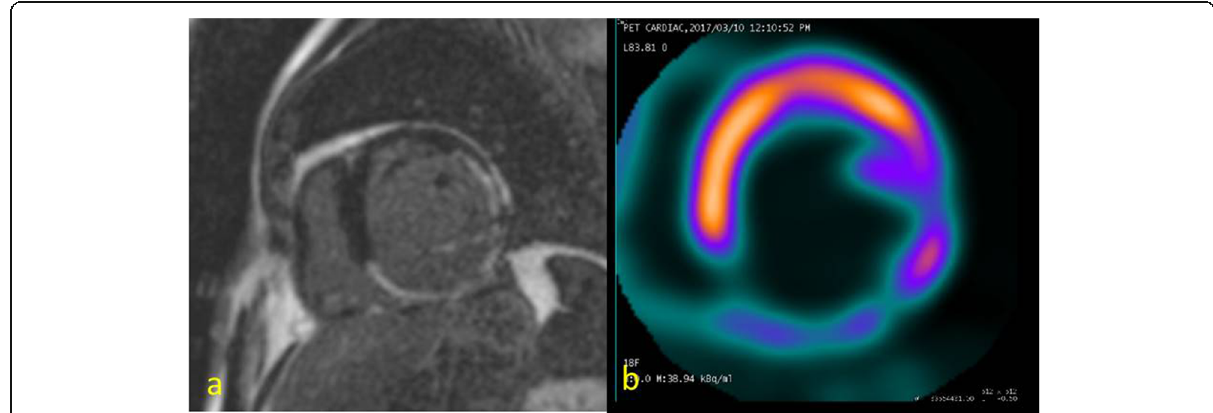
Fig. 1 A 64-year-old male with triple vessel disease. a Free-breathing delayed contrast-enhanced MRI in short-axis view reveals late gadolinium enhancement in < 50% myocardial thickness suggestive of subendocardial infarct in left circumflex and late gadolinium enhancement in complete thickness of right coronary artery territory suggestive of transmural infarct. b 18 F-FDG PET reveals normal uptake in left anterior descending artery < 50 %uptake in the right coronary artery territory and > 50 % uptake in the left circumflex territory